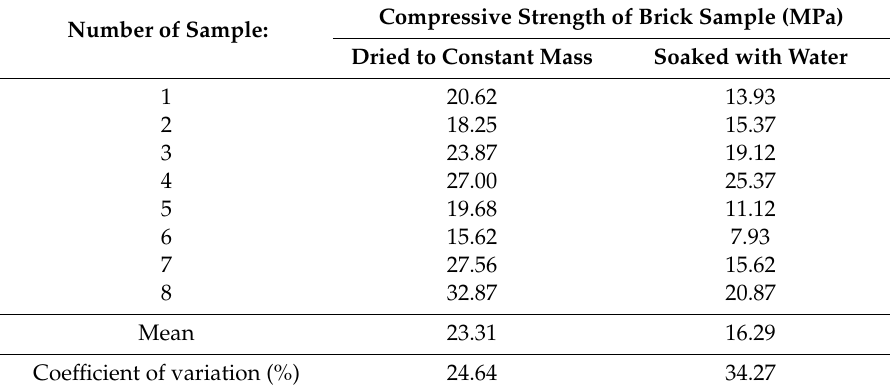
Table 1. Results of compressive strength for samples of bricks derived from the viaduct arch. Number of